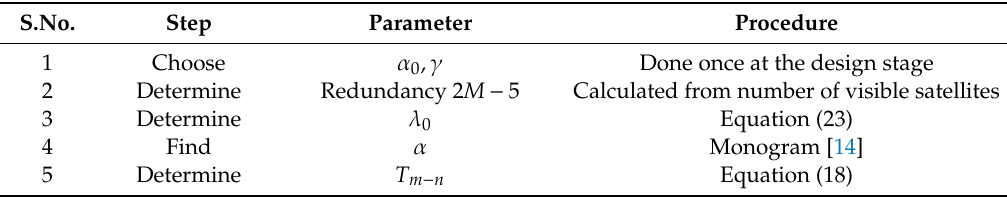
Table 1. Determining the threshold for the global